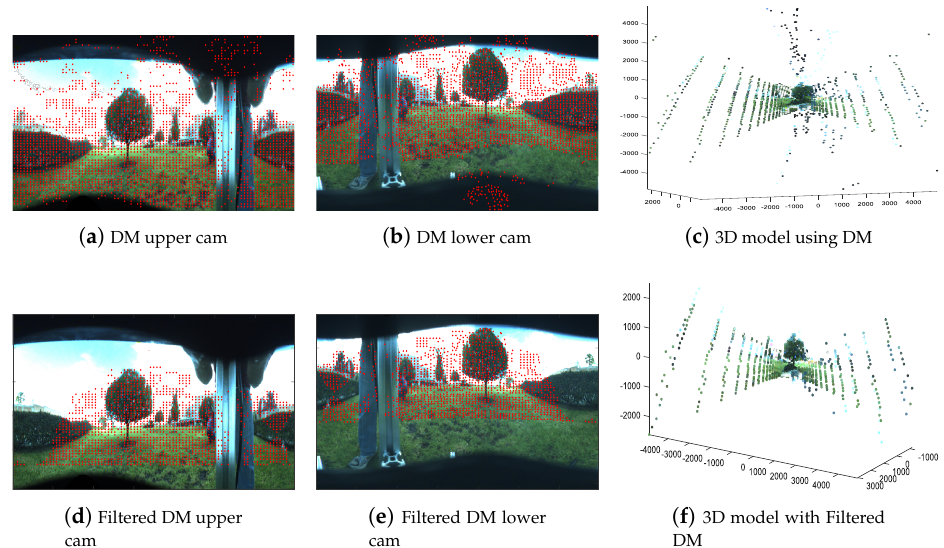
Figure 7. DeepMatching features and reconstruction. ( a , b ) show the original DeepMatching on the upper and lower camera, respectively. ( c ) shows the 3D reconstruction using the original DeepMatching. ( d , e ) show the filtered DeepMatching using epipolar constraints with d = 30 on the upper and lower cameras. ( f ) shows the 3D reconstruction using filtered DeepMatching.